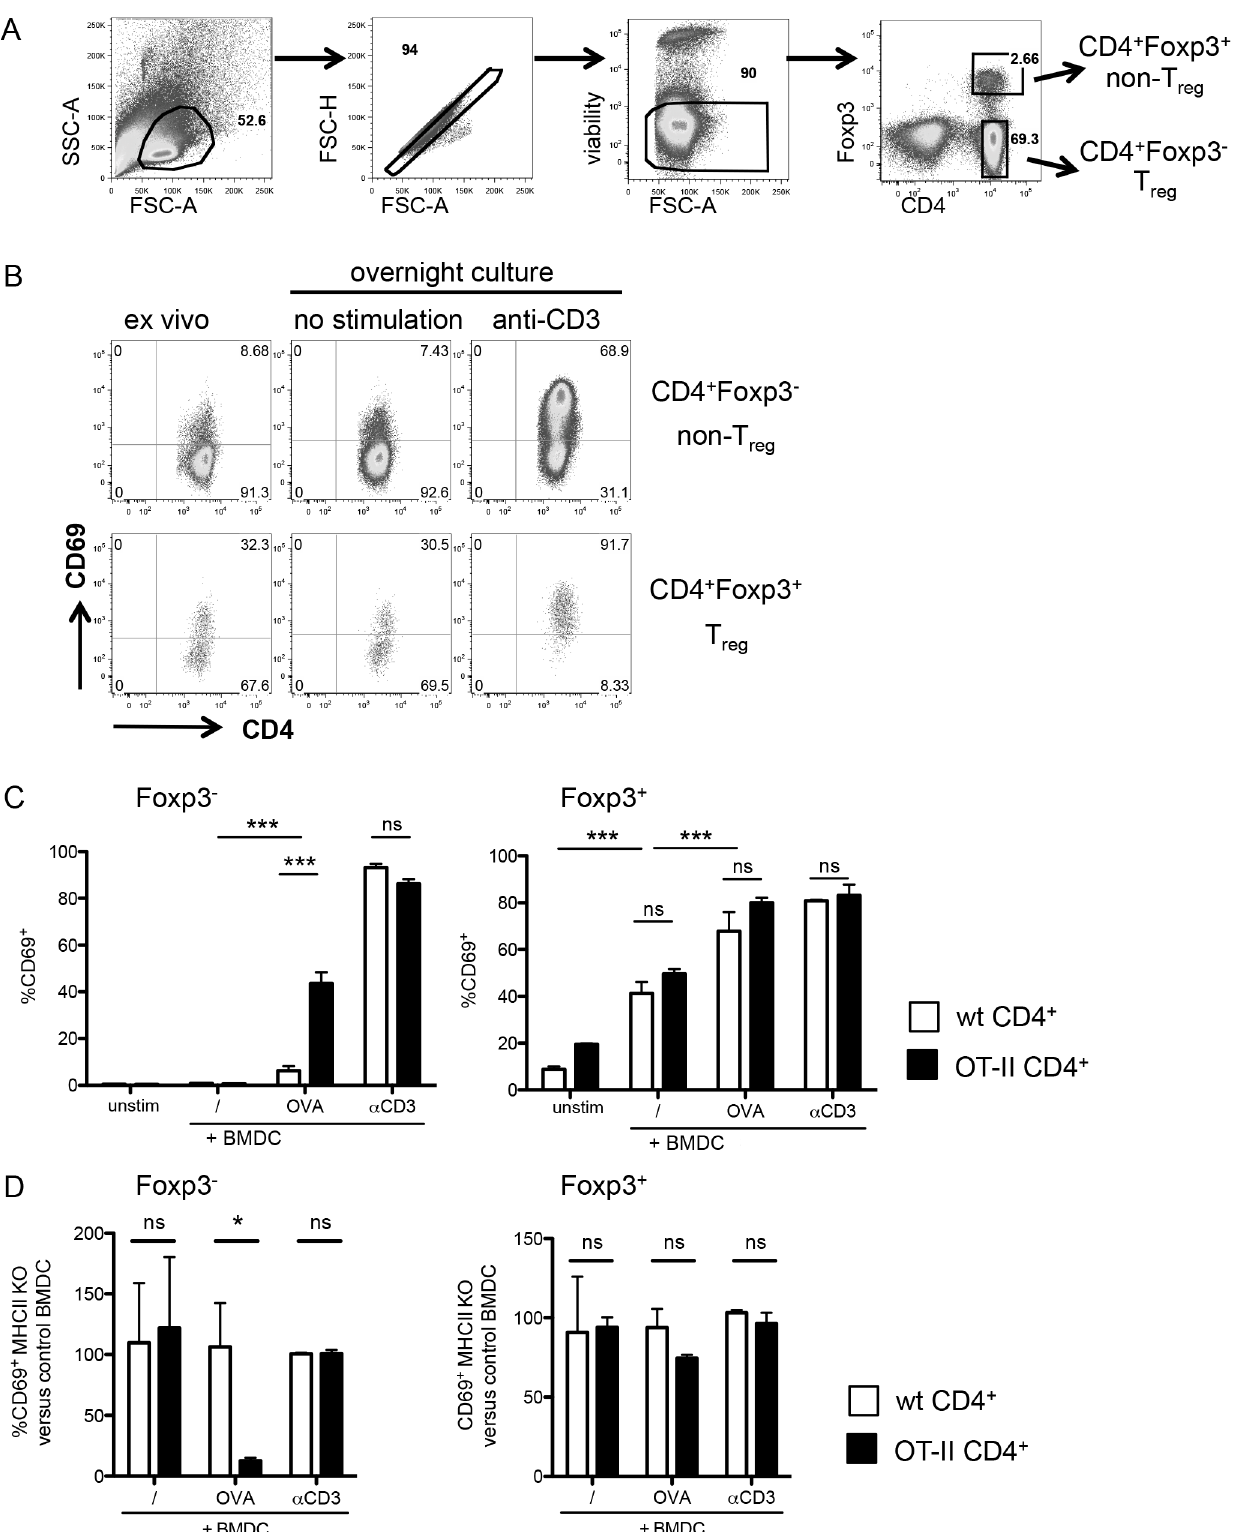
Fig 1. Foxp3 + cells upregulate CD69 after TCR activation in an antigen-non-specific manner. (A) Gating strategy on CD4 + enriched T cells after overnight culture without stimulation. Cells are gated in the lymphocyte gate based on forward versus side scatter, then doublets are excluded based on